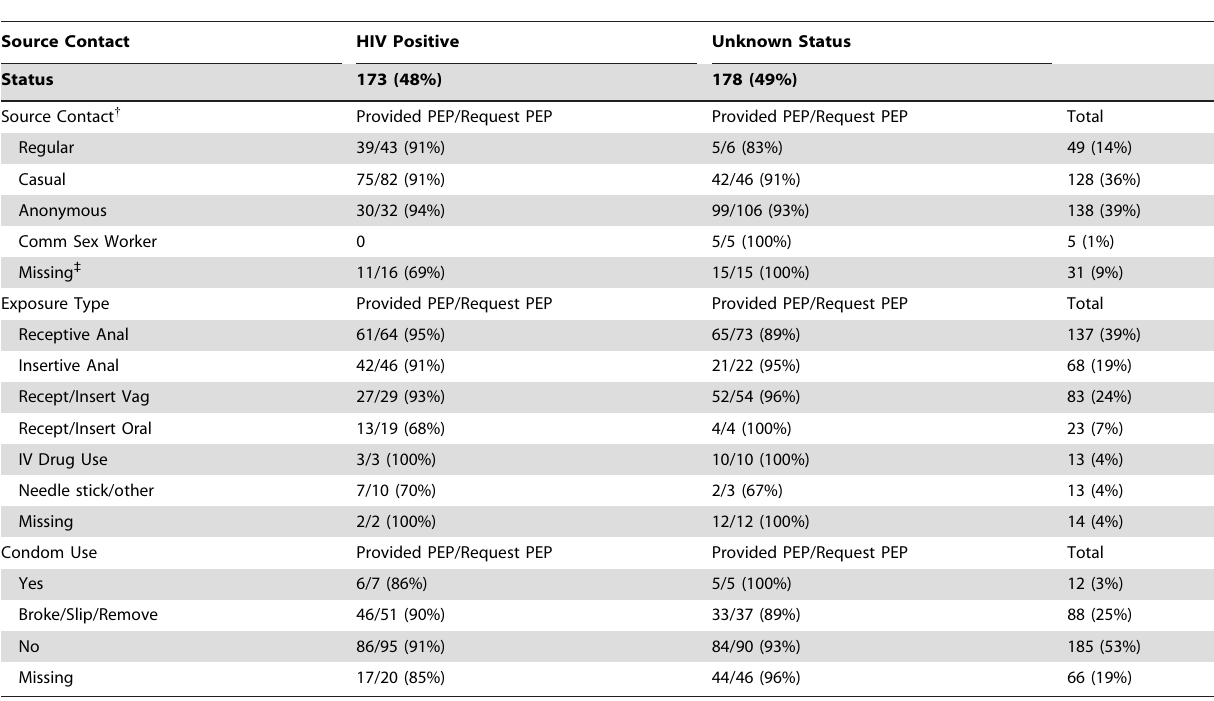
Table 2. Risk behaviors among patients exposed to HIV-positive contact or contact with unknown HIV status (N